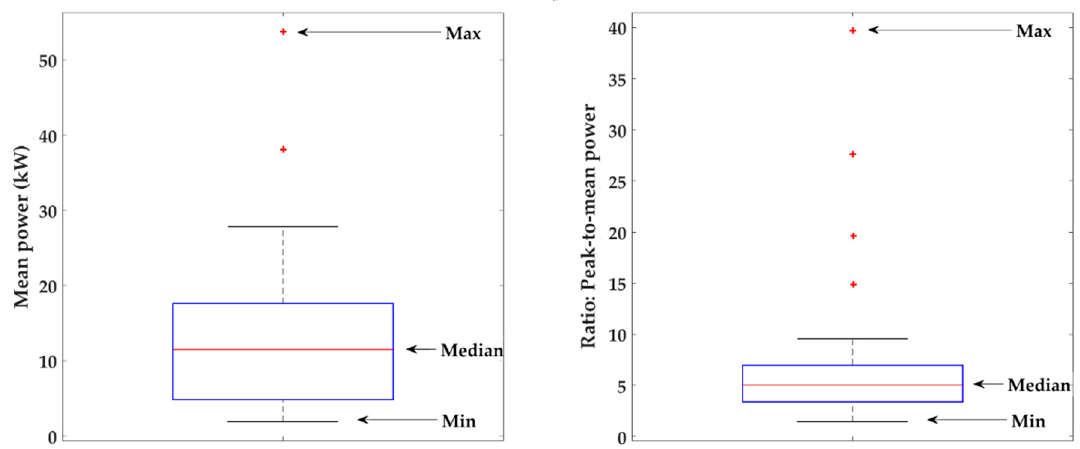
Figure 1. Boxplots, 40 load profiles–( a ) Mean power (left), ( b ) Ratio: Peak-to-mean power (right).